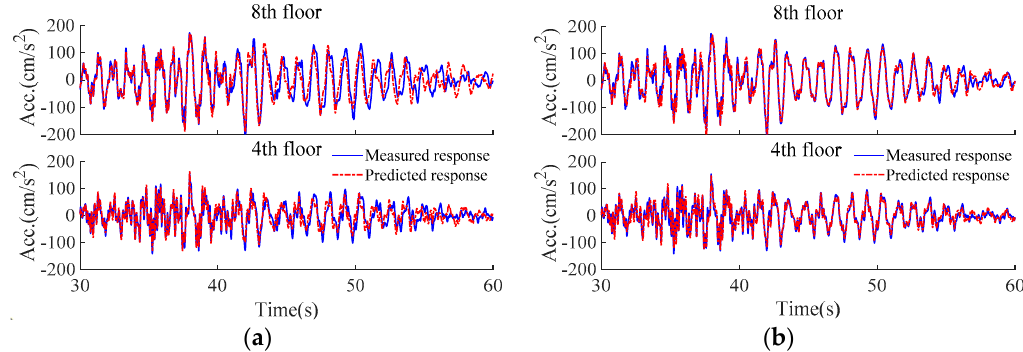
Figure 8. Comparison of the predicted and measured floor acceleration: ( a ) updated model I; ( b ) updated model II.